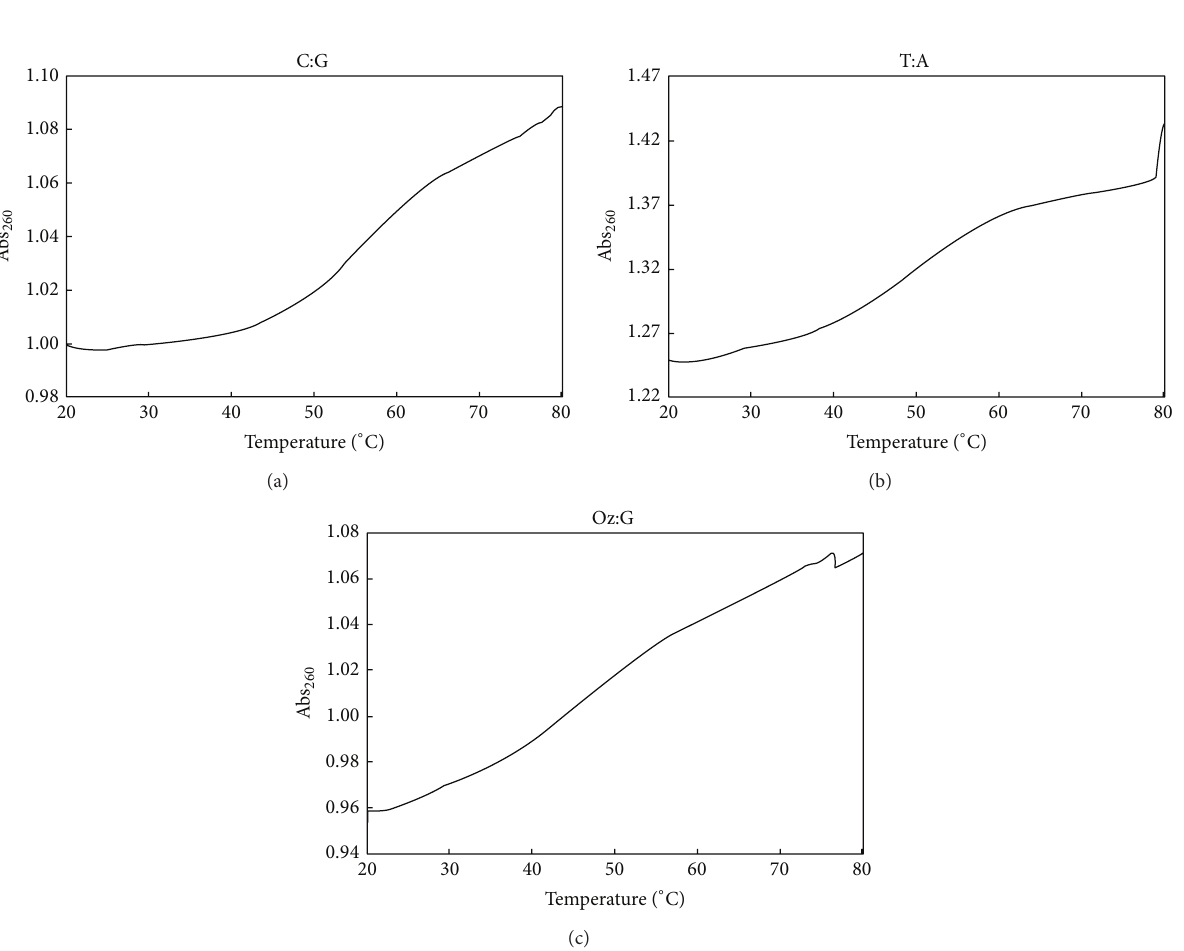
Figure 5: Melting curves of (a) C:G, (b) T:A, and (c) Oz:G 9-mer DNA duplexes at 4 𝜇 M duplex